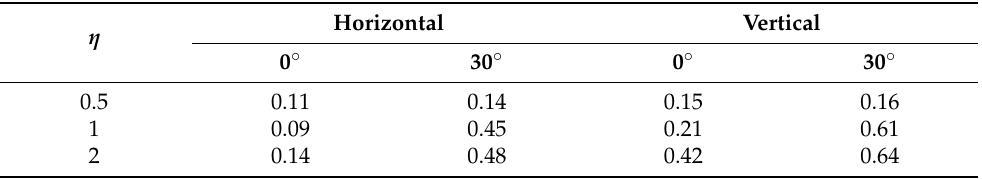
Table 2. Mean variation coefficient of horizontal and vertical displacement amplitude (random permeability